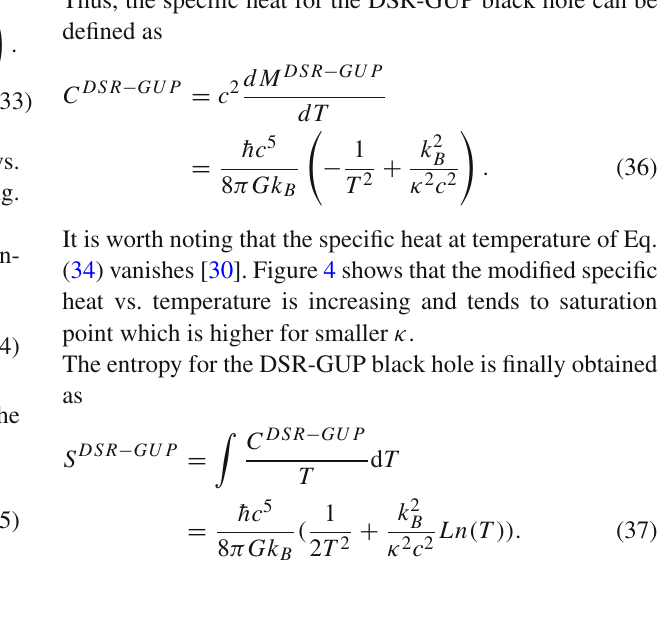
Fig. 3 Plot of the modified mass-temperature relation for the M DSR − GUP with κ = 0 . 15 , 0 . 25 and 0 . 35 where we set ¯ h = c = k B = G = 8 π =